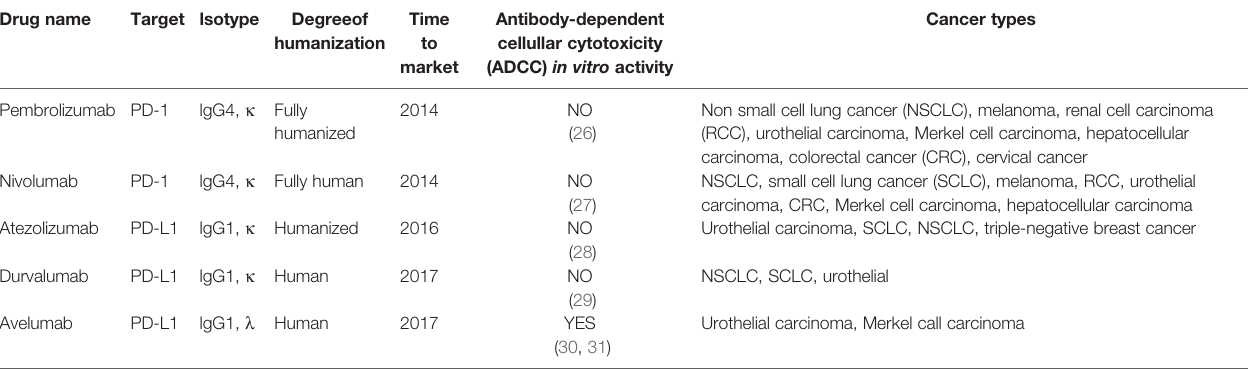
TABLE 1 | Anti-PD-1/PD-L1 monoclonal antibodies (mAbs) in anti-cancer immunotherapy. Drug name Target